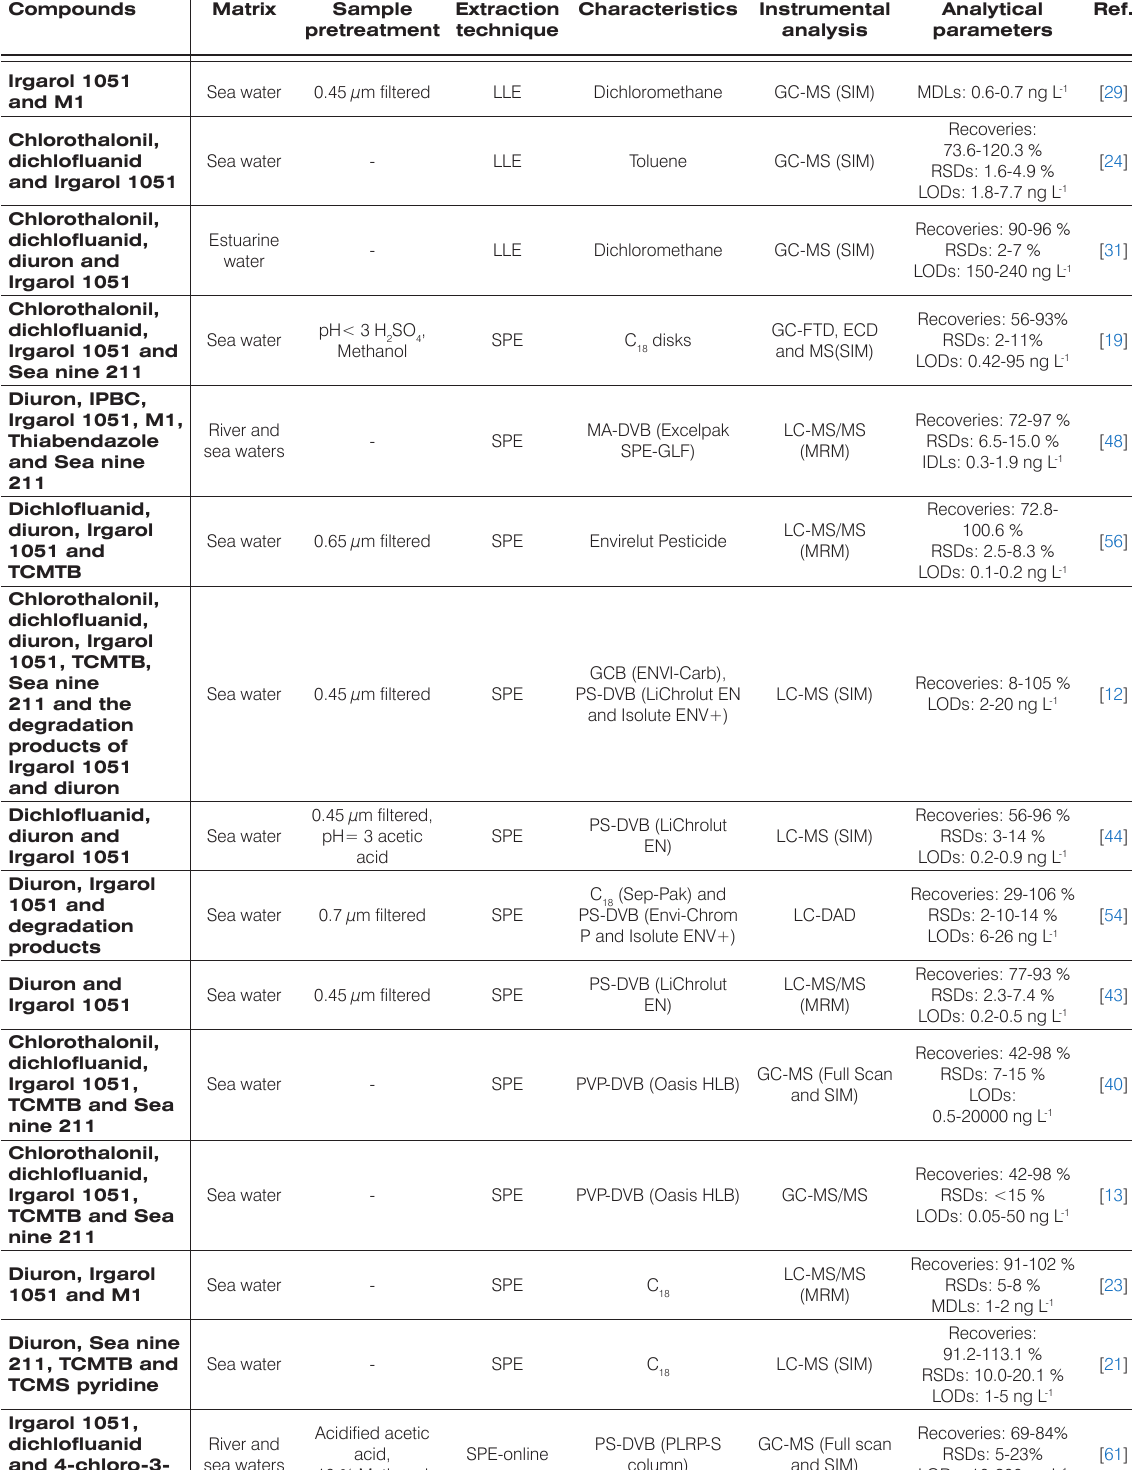
Table 2. Methods for the extraction and determination of common booster biocides in liquid and solid samples. Compounds Matrix Sample Extraction Characteristics Instrumental pretreatment technique